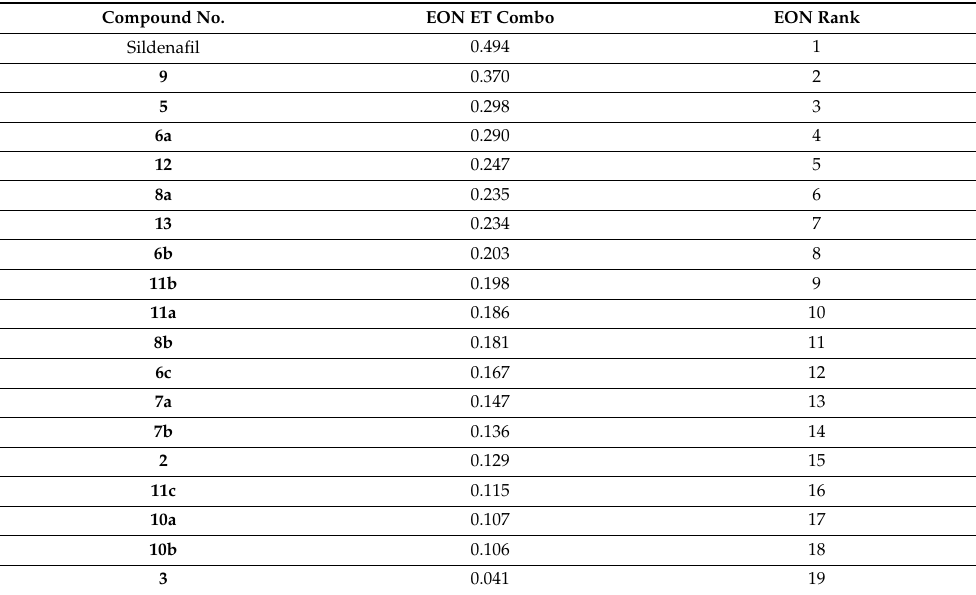
Table 2. The OpenEyes’s EON scores of target compounds against sildenafil as a reference drug. Compound